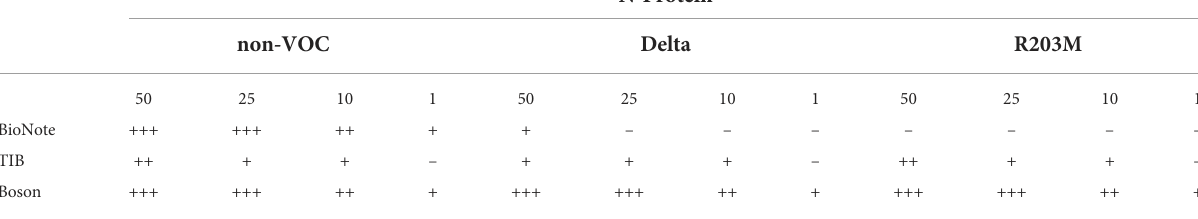
TABLE 7 Summary of RAT sensitivity for N-protein from non-VOC, Delta, and non-VOC carrying the R203M amino acid exchange. N-Protein non-VOC Delta R203M